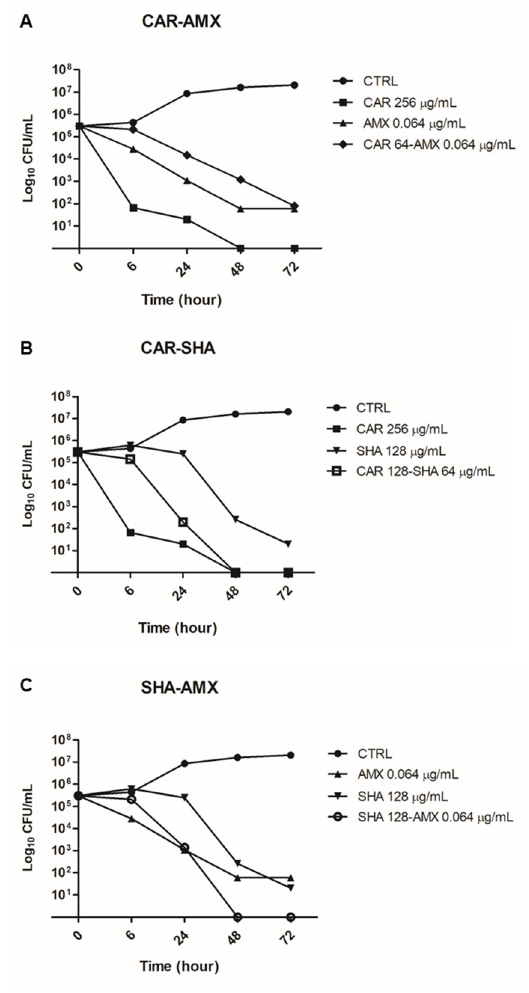
Figure 1. Bactericidal curves of the three compounds and their combinations vs. H. pylori ATCC 43504. ( A ) CAR and AMX alone and in association; ( B ) CAR and SHA alone and in association; ( C ) SHA and AMX alone and in association.